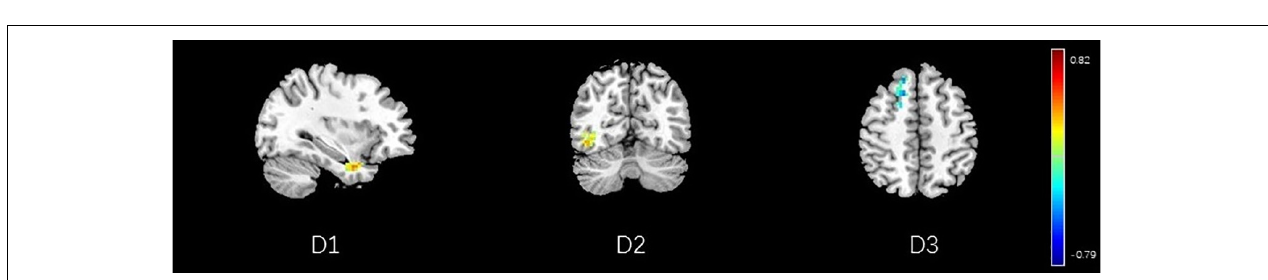
FIGURE 14 | Regions showing significant correlation with the pain score of nocebo response in female participants. Color scale represents the correlation coefficient. Red = positive correlation; blue = negative correlation. C1: right parahippocampal gyrus, C2: left parahippocampal gyrus, C3: middle temporal lobe, C4: secondary somatosensory area.